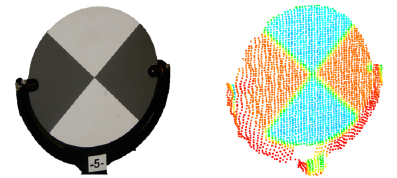
Figure 1. Left : image of a plane black and white target with checkerboard pattern (Leica Tilt&Turn-Target), right : scanned point cloud of the target